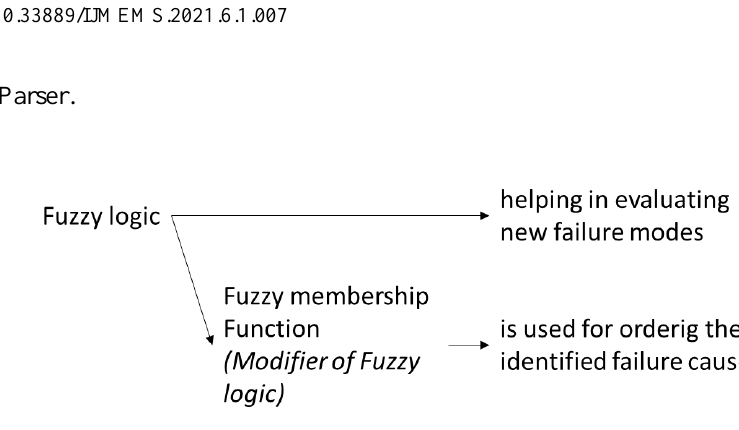
Figure 4. Identification of different goals from FMEA integrations with “Fuzzy logic” and “Fuzzy Membership Function”.